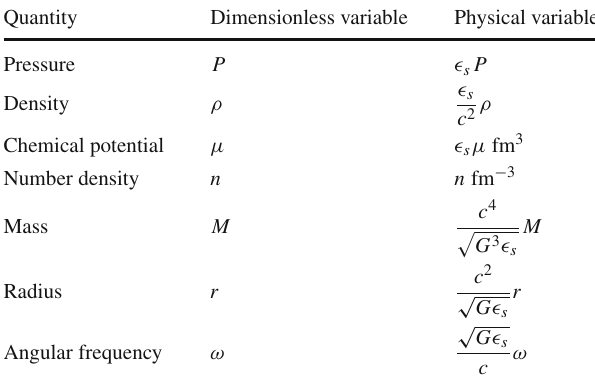
Table 4 Conversion table of physical quantities for (cid:3) s in GeVfm −